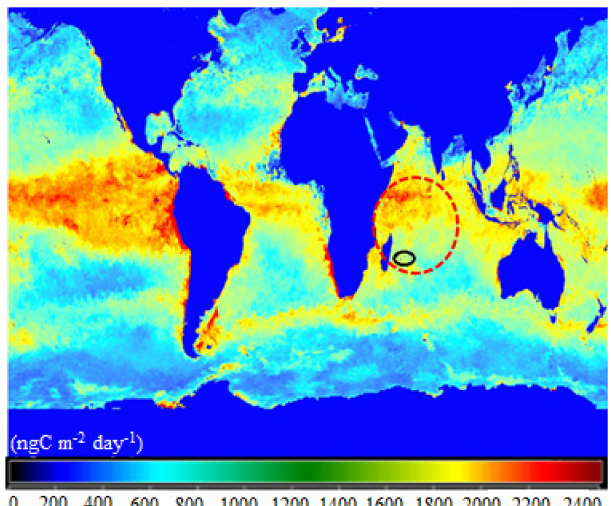
Figure 1. Annual average of marine primary productivity for the year 2018. The colors in the map explain the productiv- ity condition of the ocean. Blue (0–1200ngCm − 2 d − 1 ), green (1200–1800ngCm − 2 d − 1 ), and from yellow to red (1800– 2400ngCm − 2 d − 1 ) colors indicate oligotrophic, mesotrophic, and eutrophic states of the oceanic regions, respectively (Carr et al., 2006; Istvánovics, 2009). The dashed red circle indicates a region of Indian Ocean with high primary productivity and black circle in- dicates the location of the Maïdo high-altitude observatory. The fig- ure was produced and adapted from the NASA’s OceanColor Web (http://oceancolor.gsfc.nasa.gov/cgi/l3, last access: 7 July